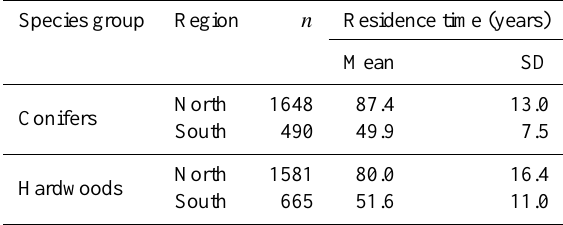
Table 2. Baseline estimates of downed woody debris residence times, assuming a static-climate